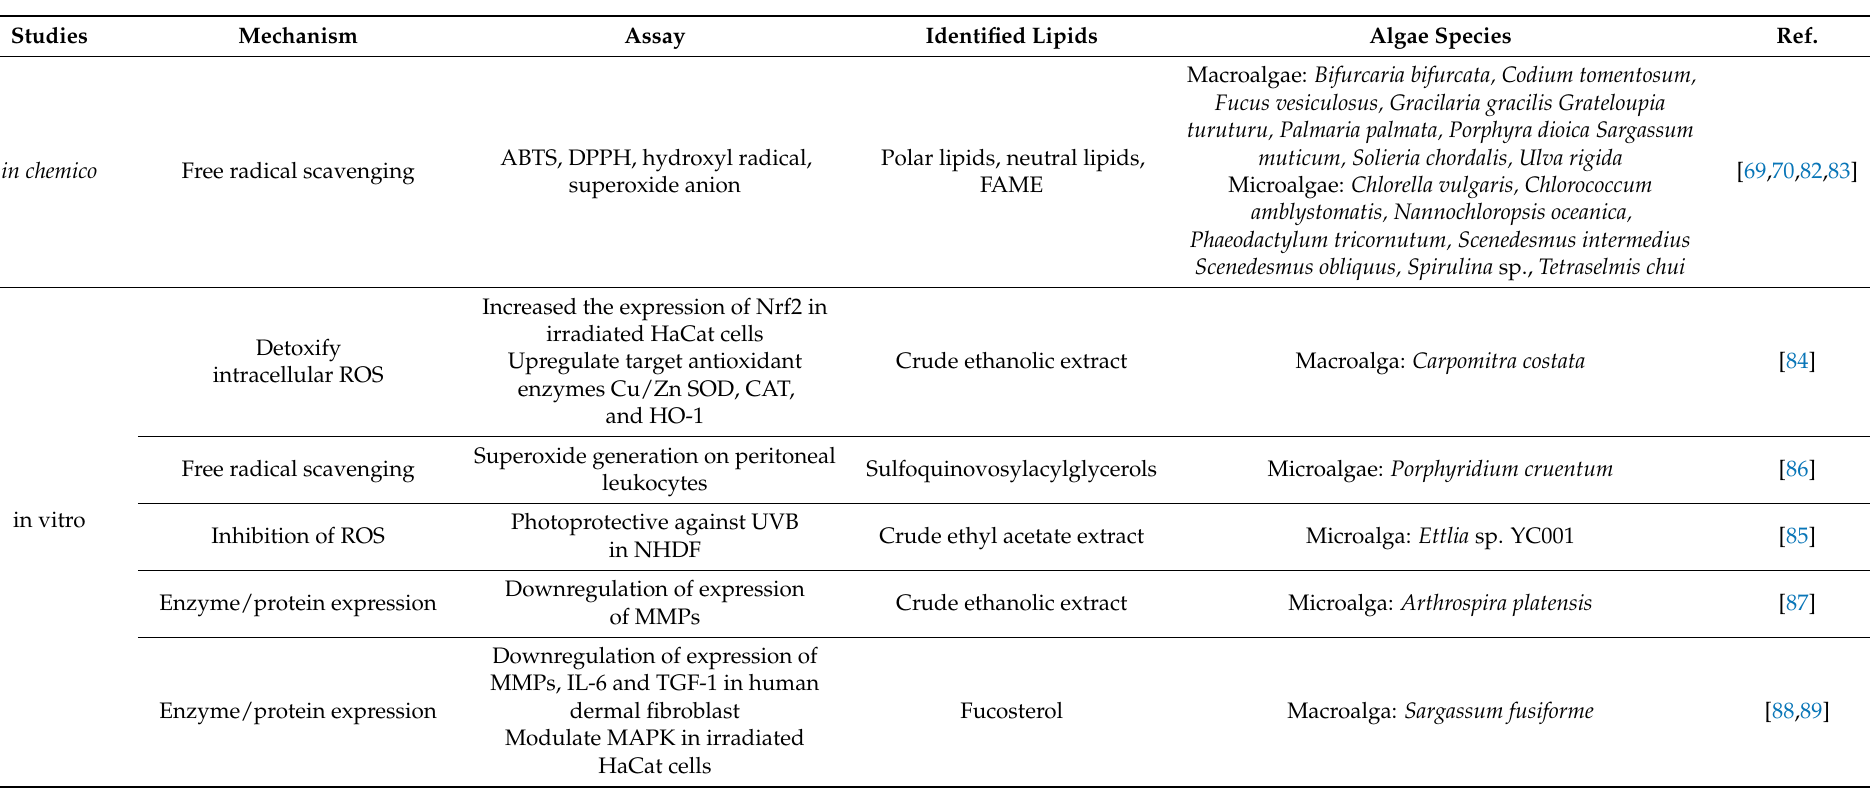
Table 1. Lipid extracts of algae with antioxidant activity tested in chemico and in vitro with potential application on skin diseases. Abbreviations: ABTS—2,2 (cid:48) -azino- bis(3-ethylbenzothiazoline-6-sulfonic acid, CAT—catalase, DPPH—2,2-diphenyl-1-picrylhydrazyl, FAME—fatty acyl methyl esters, HO-1—heme oxygenase-1, IL-6—interleukin-6, MAPK—mitogen-activated protein kinase, MMP—metalloproteinase, NHFD—normal human dermal fibroblasts, ROS—reactive oxygen